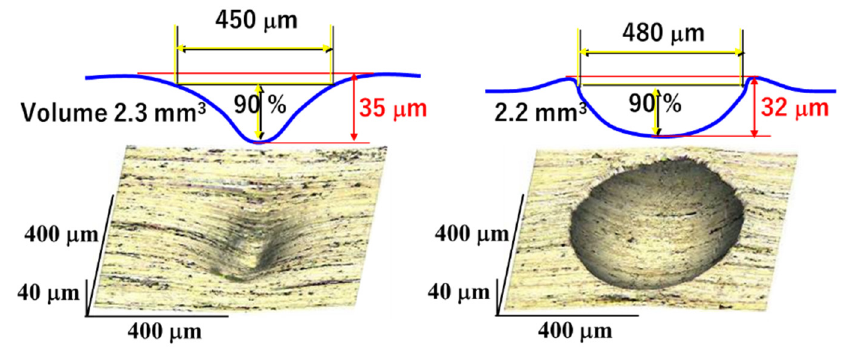
Figure 22. Typical aspect of plastic deformation pit induced by cavitation impact in comparison with ball indentation. ( a ) Cavitation impact; ( b ) Ball indentation.